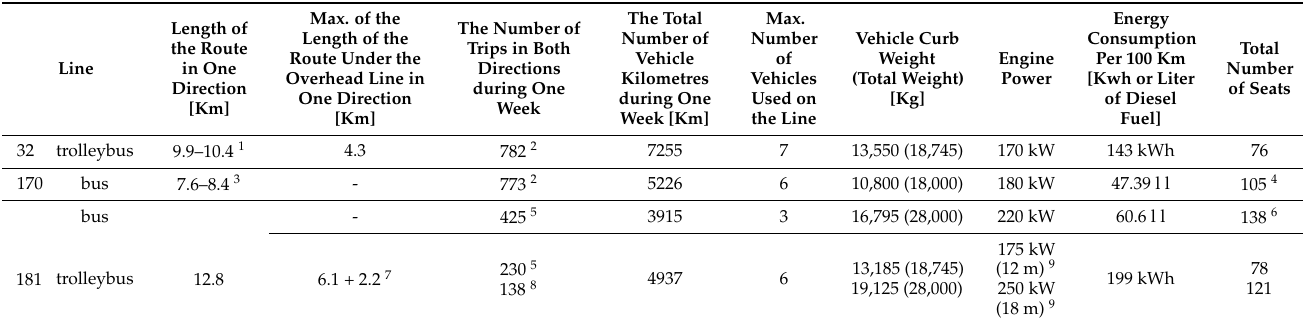
Table 4. Characteristics of the functioning of the analysed lines 32 (170) and 181 (source: Own elaboration based on unpublished exploitation materials).